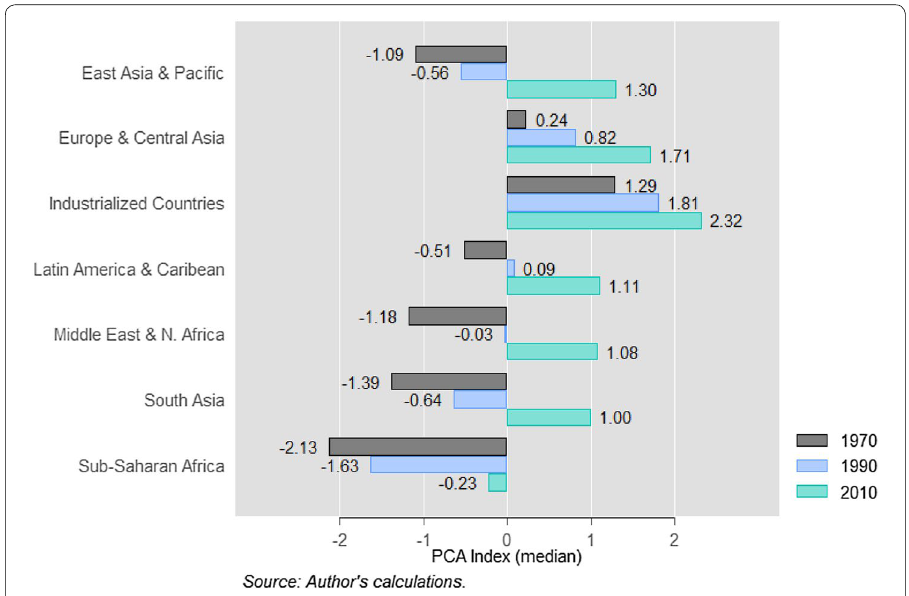
Fig. 7 Principal component analysis